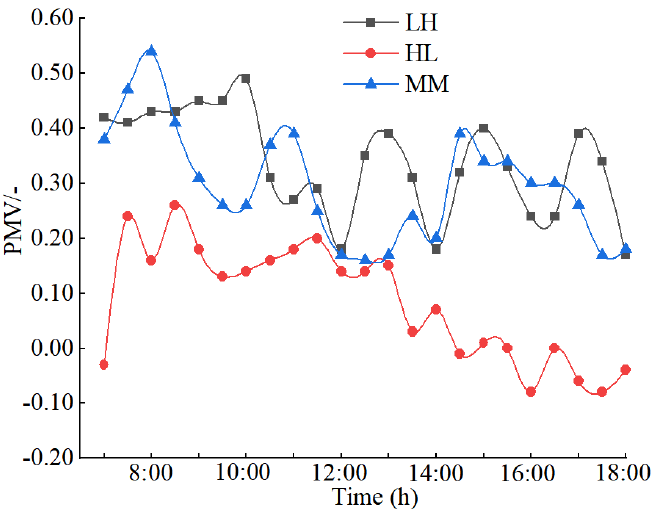
Figure 13. Thermal comfort under different operating strategies.